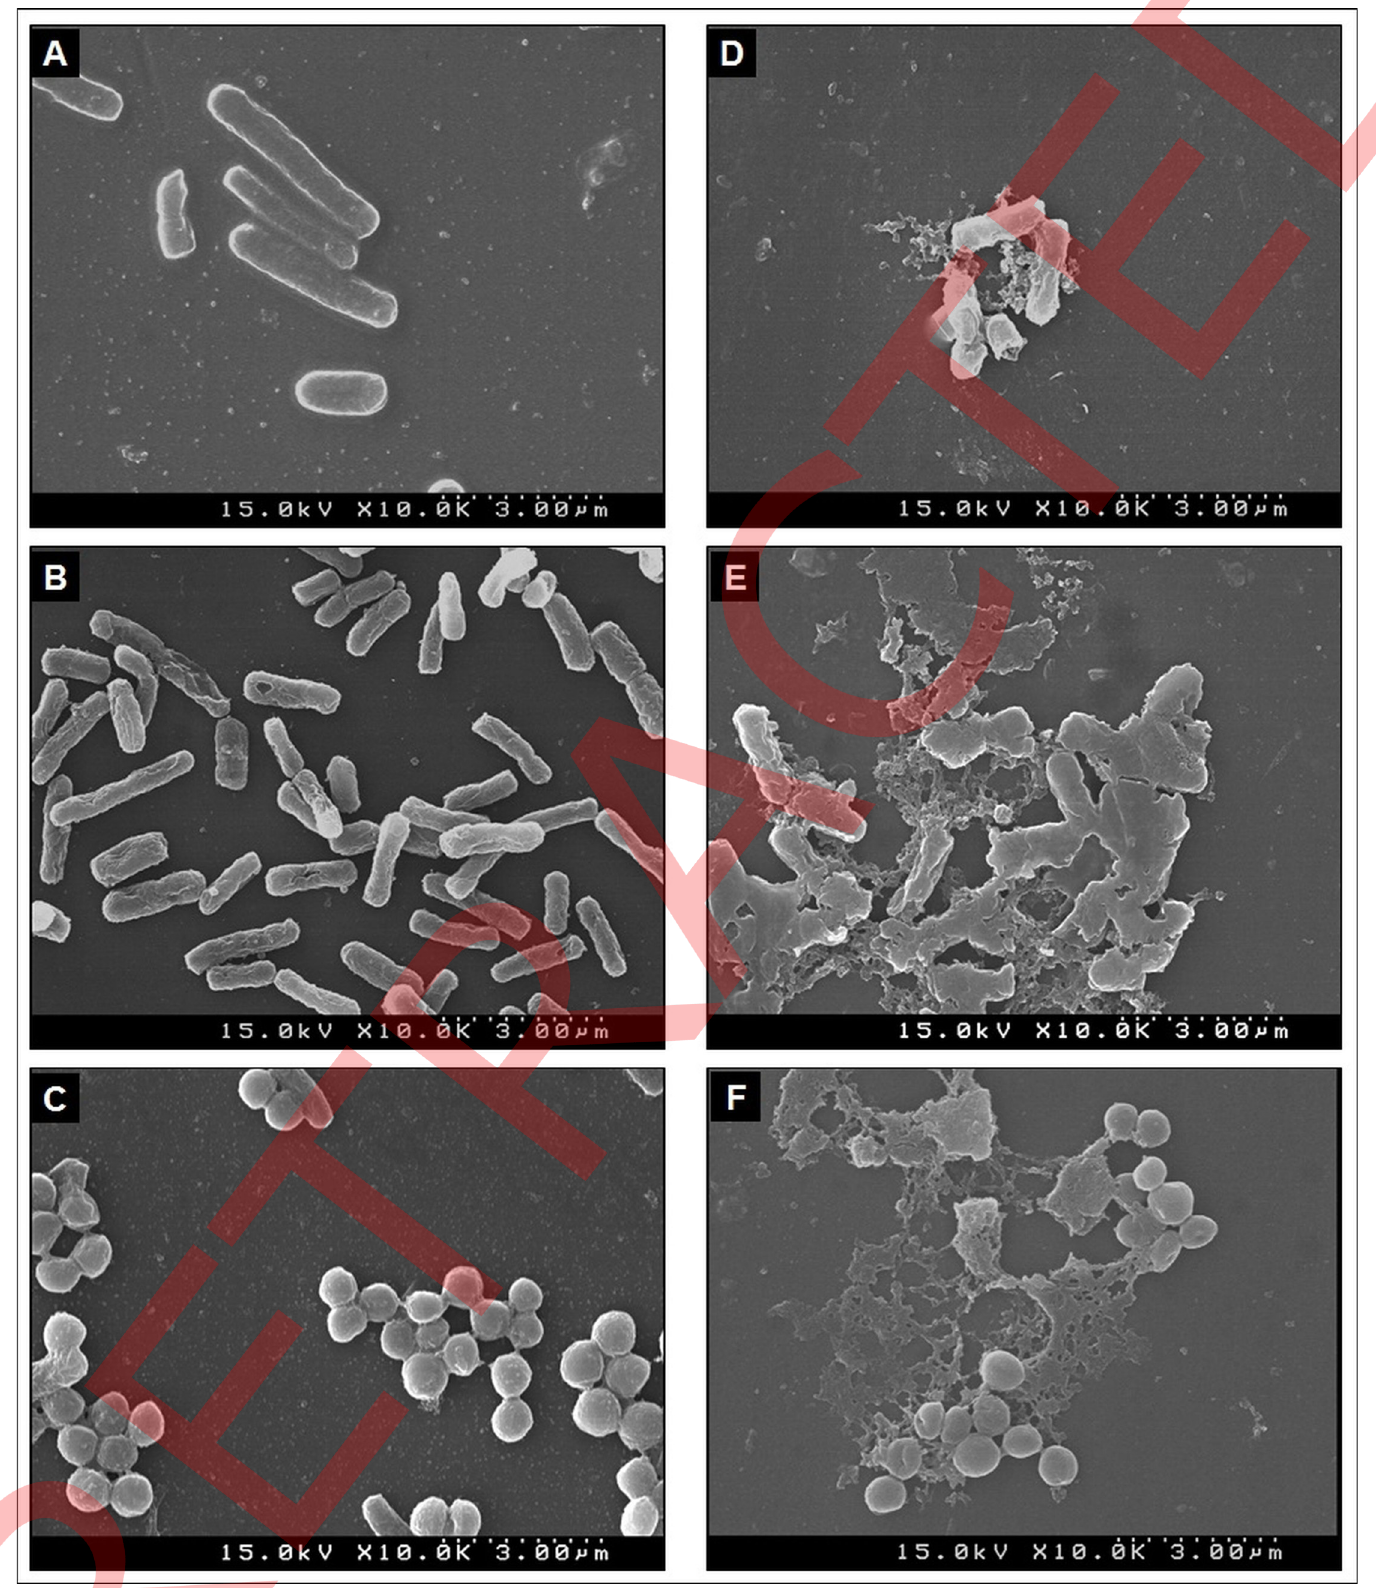
Fig 9. SEM image of the untreated control bacteria (A,B,C) and the CPG-S NPs treated foodborne pathogenic bacteria (D,E,F). B . cereus ATCC 13061 (A,D); E . coli ATCC 43890 (B,E); S . aureus ATCC 49444 (C,F). https://doi.org/10.1371/journal.pone.0217318.g009 PLOS ONE | https://doi.org/10.1371/journal.pone.0217318 June 10,